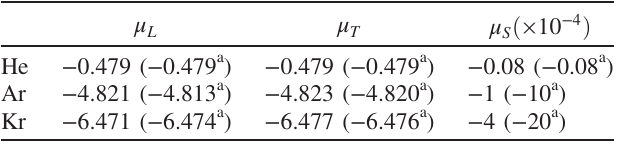
TABLE III. Flexoelectric coefficients (in pC/m) of noble-gas atom systems.